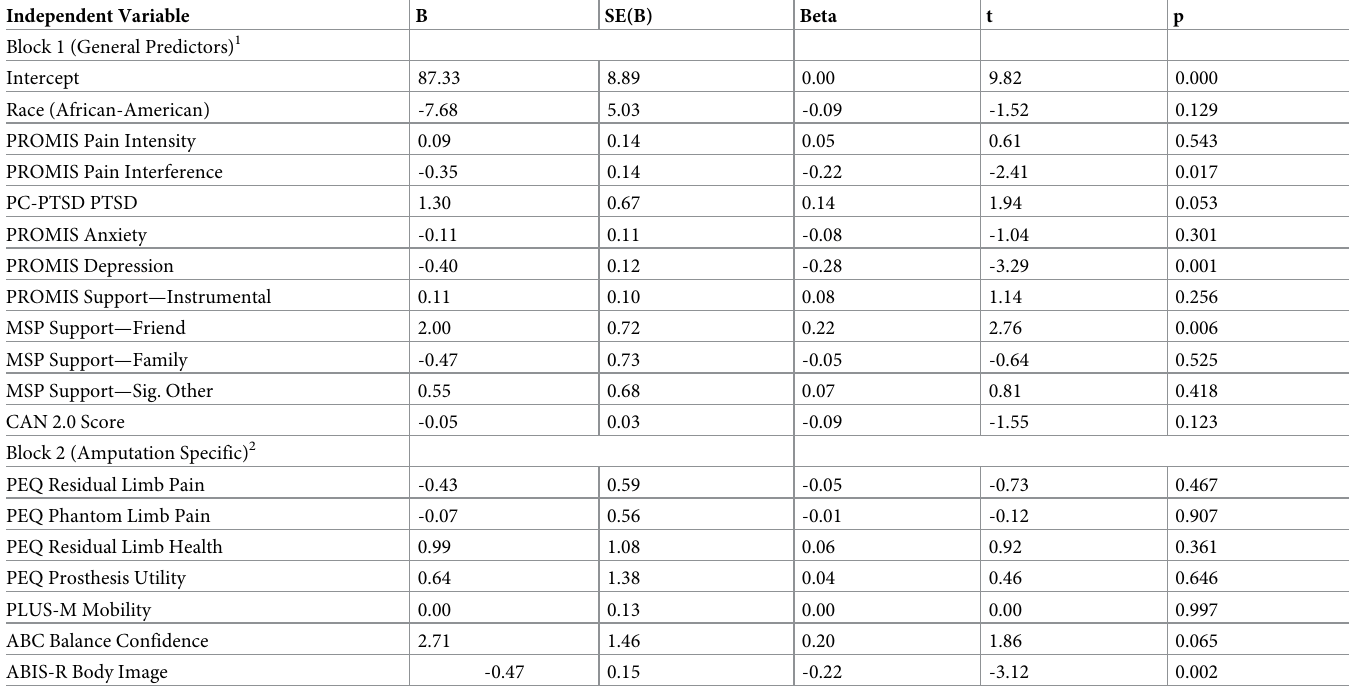
Table 5. Regression of CPI control on general and specific